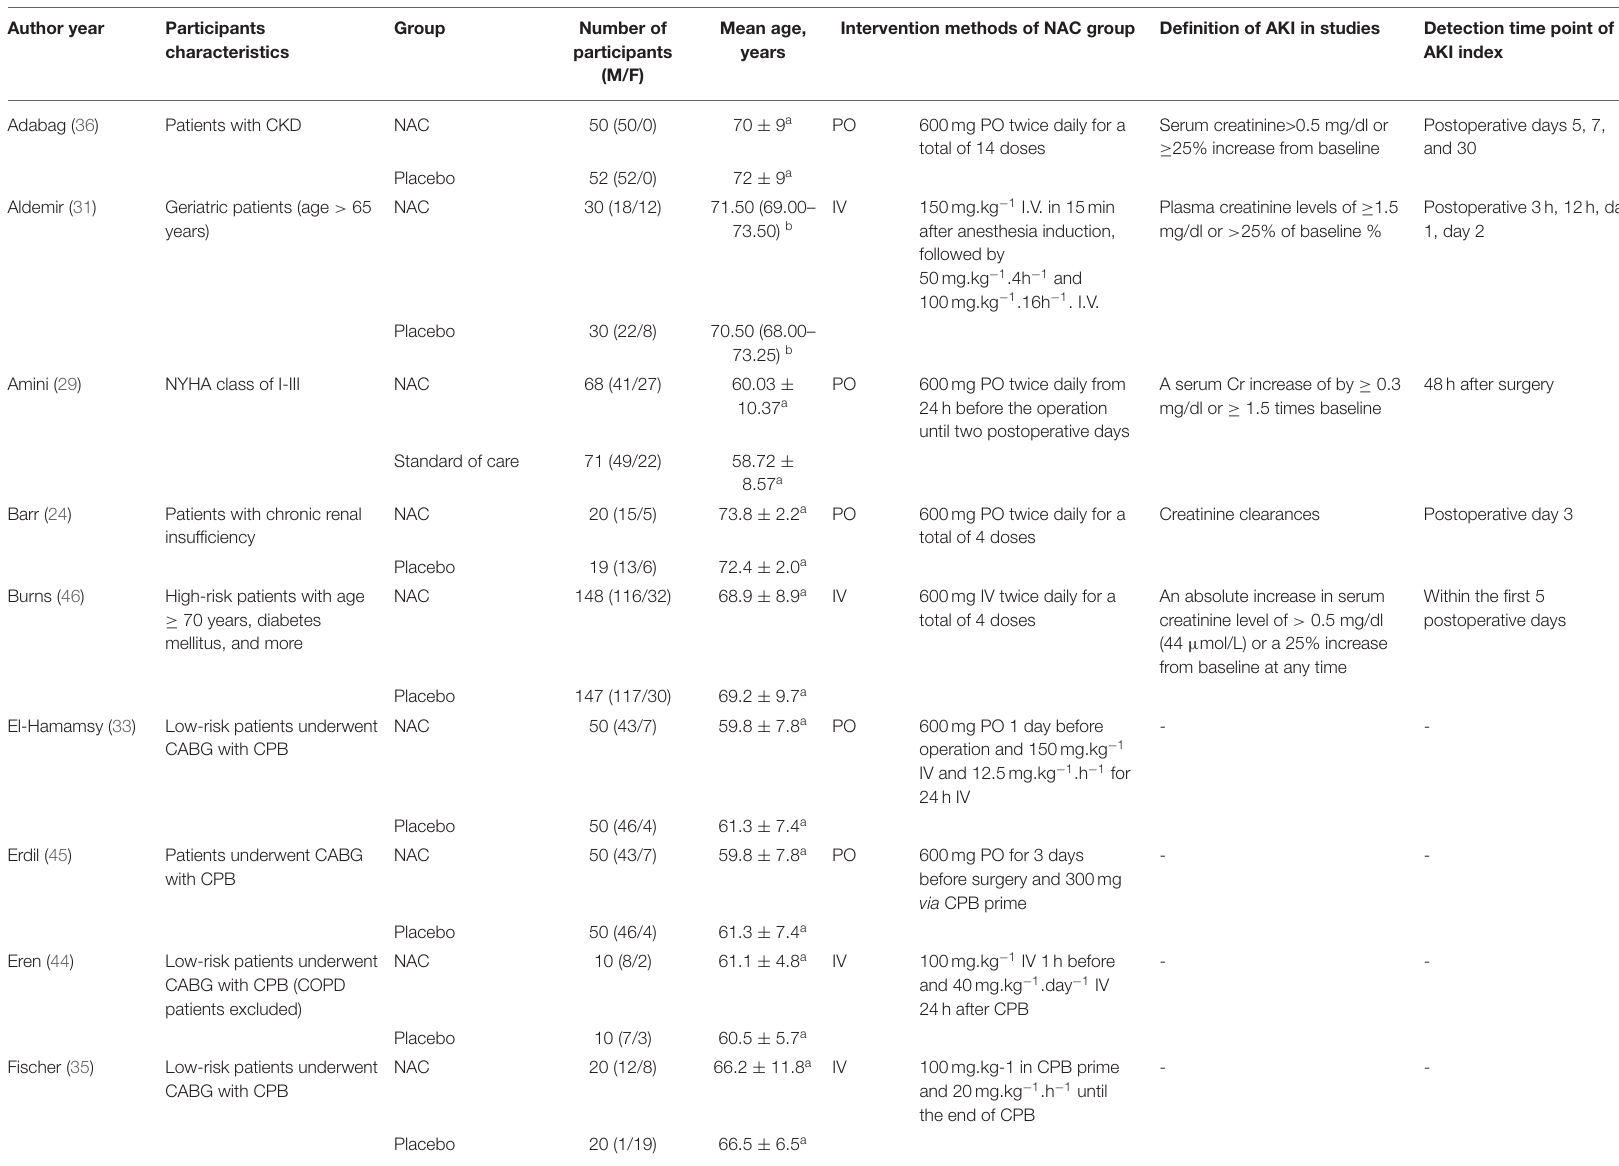
TABLE 1 | Characteristics of included